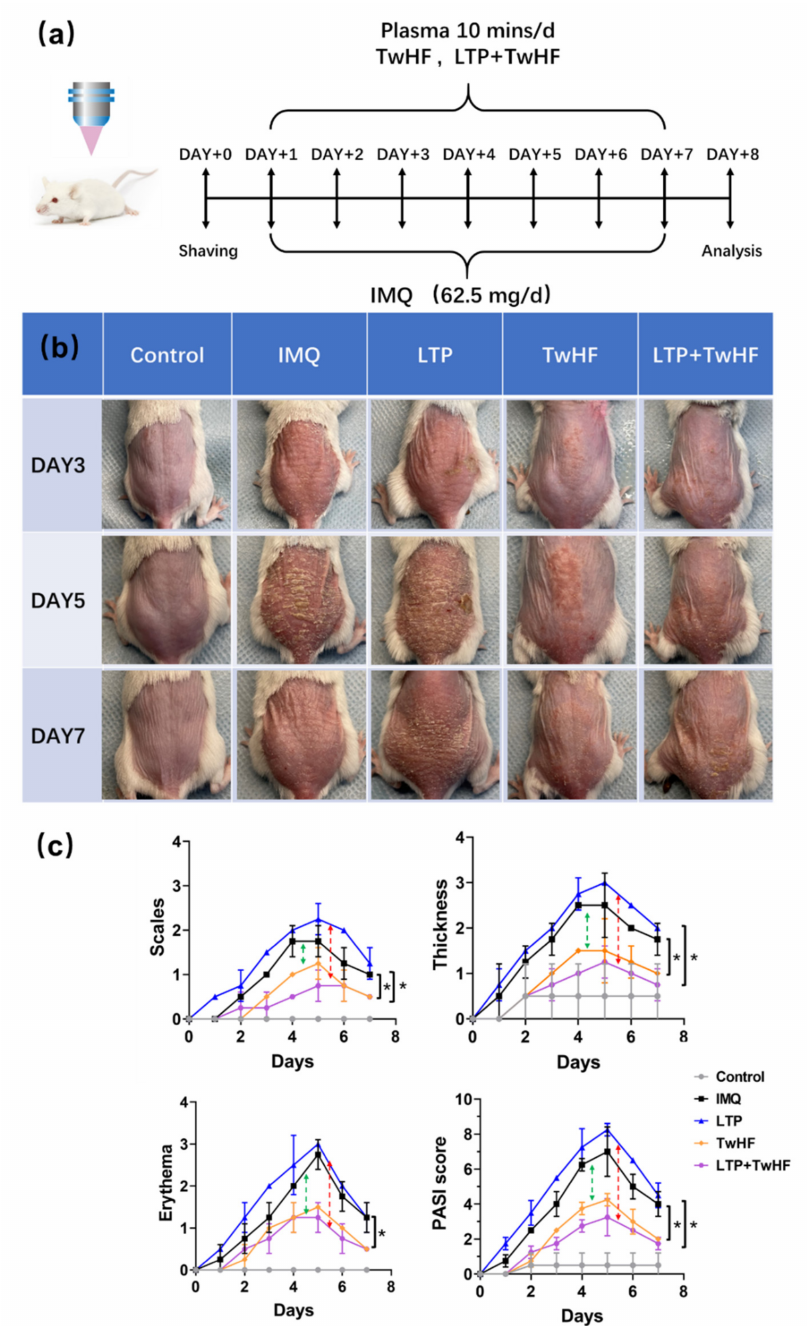
Figure 7. LTP + TwHF ameliorates psoriatic symptoms and skin inflammation in IMQ-induced psori- atic mice. ( a ) Flow chart of the experiment. ( b ) The back skin photos of mice were taken on the 3rd, 5th 7th day after IMQ painting. ( c ) PASI scores in all groups of mice were evaluated daily and the statisti- cal difference between all groups was indicated. Data are expressed as mean ± SD ( n = 5 mice/group, * p < 0.05). One representative of three separate experiments is shown while all results were similar among these three experiments. Because the LTP treatment enhanced the transdermal delivery of IMQ, the psoriasiform dermatitis became more serious after the LTP treatment. TwHF group only alleviated mild symptoms of the IMQ model. The comparison between the red dash line and green dash line suggests that the LTP + TwHF psoriasiform dermatitis is more efficient at suppressing epidermal thickening and inhibiting systemic